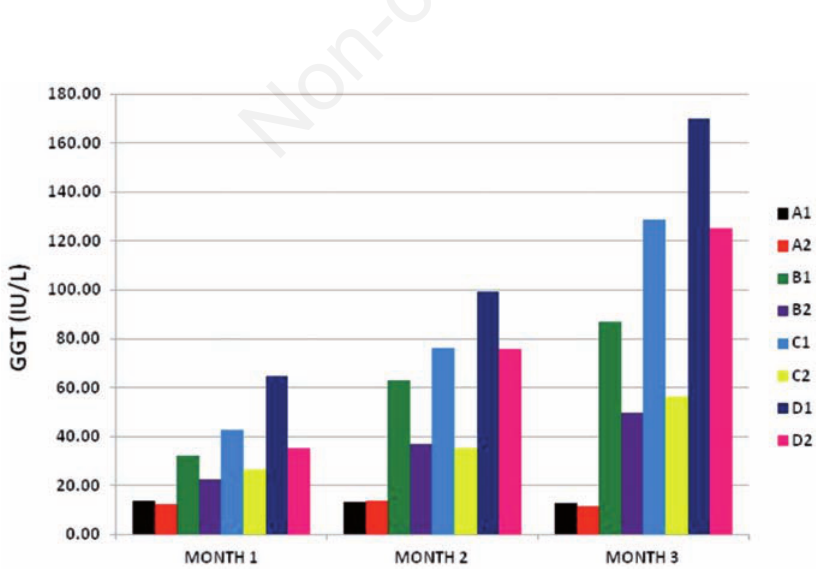
Figure 4. Gamma-glutamyltransferase (GGT enzyme) activity values for 3 months study